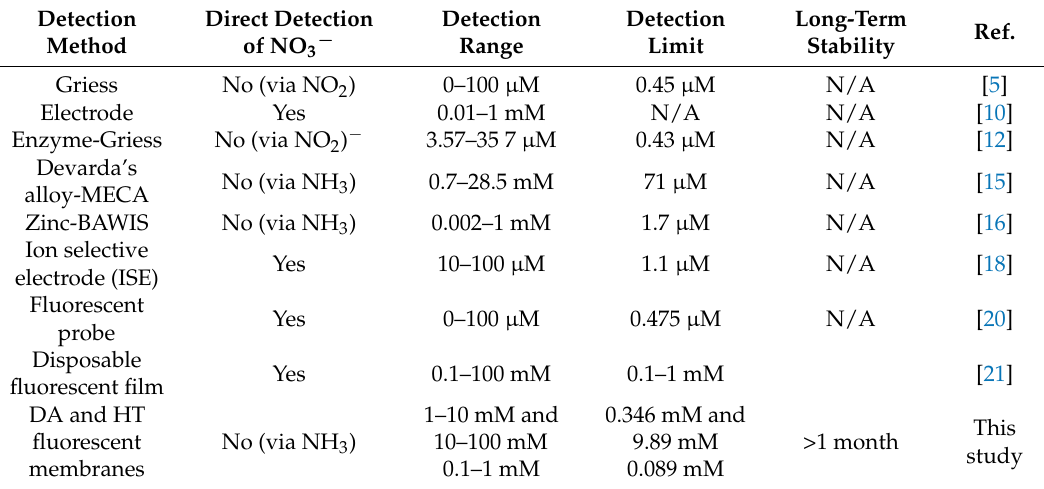
Table 1. Summary of certain nitrate sensors.